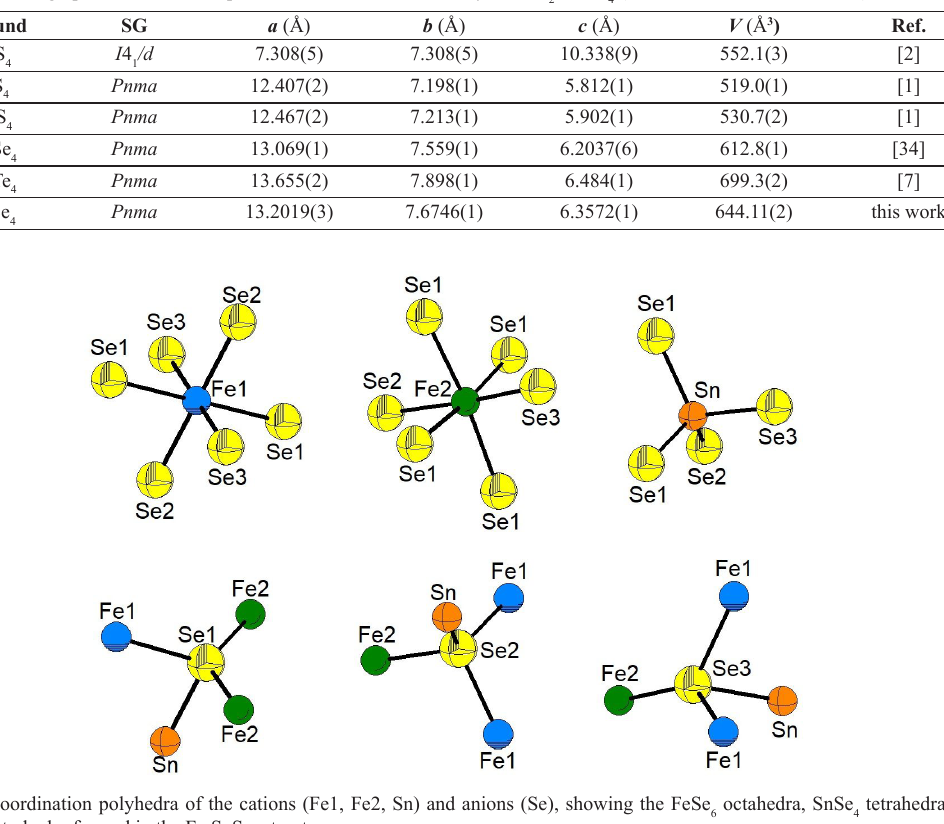
SnSe structure. 2 4